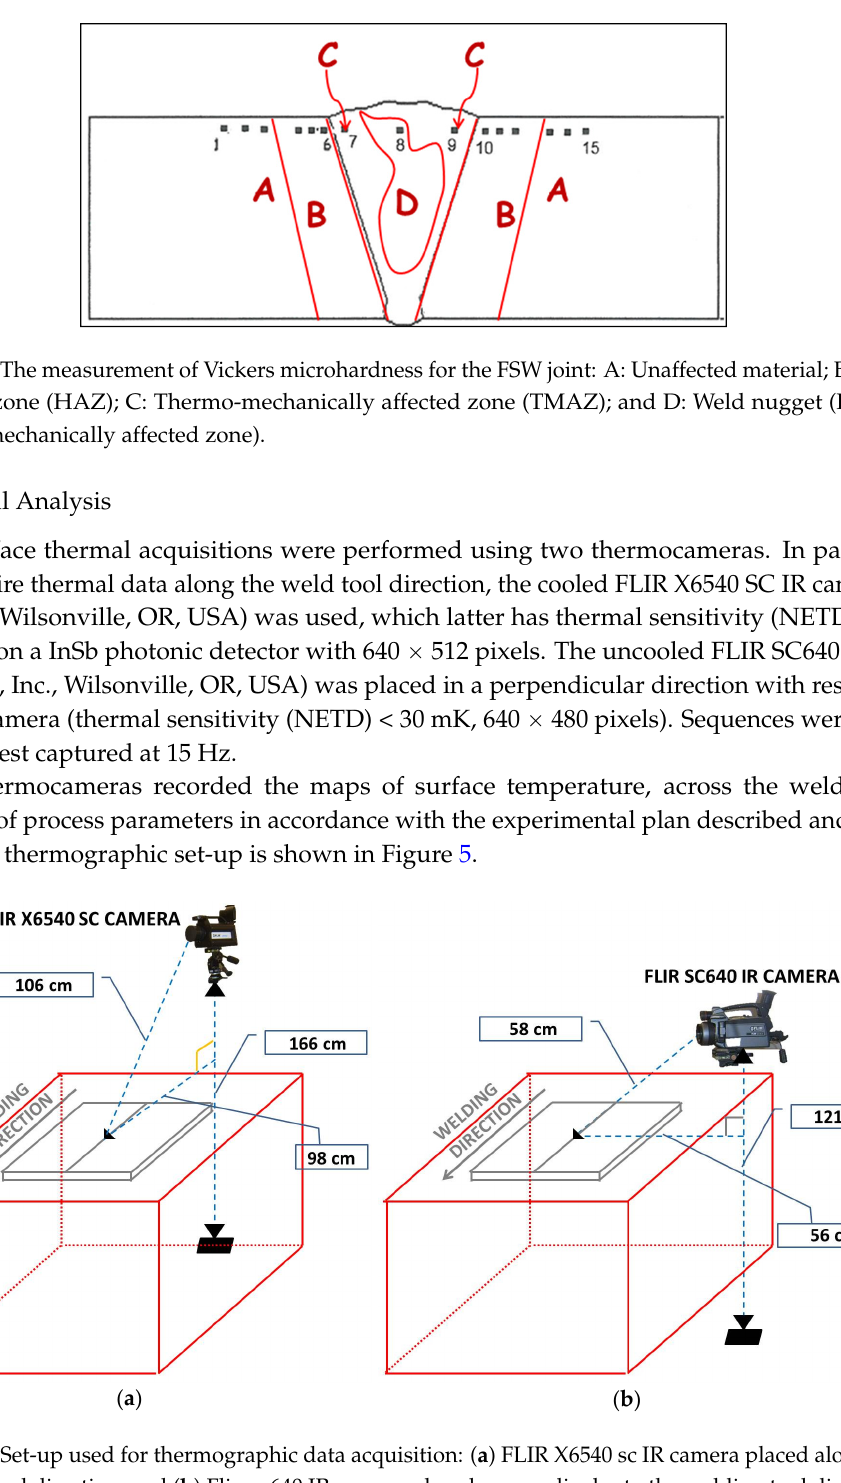
Figure 5. Set ‐ up used for thermographic data acquisition: ( a ) FLIR X6540 sc IR camera placed along the welding tool direction; and ( b ) Flir sc 640 IR camera placed perpendicular to the welding tool direction.